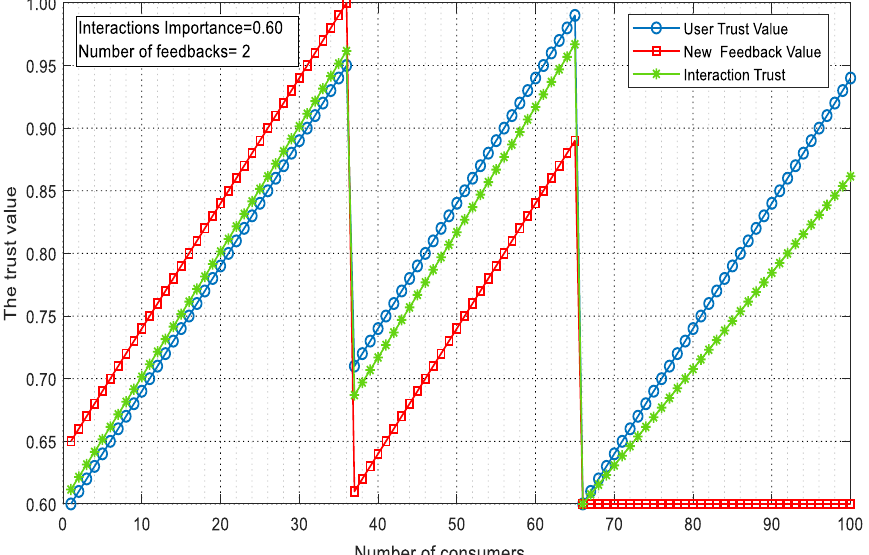
Figure 3. Interaction trust values for 100 trusted consumers.